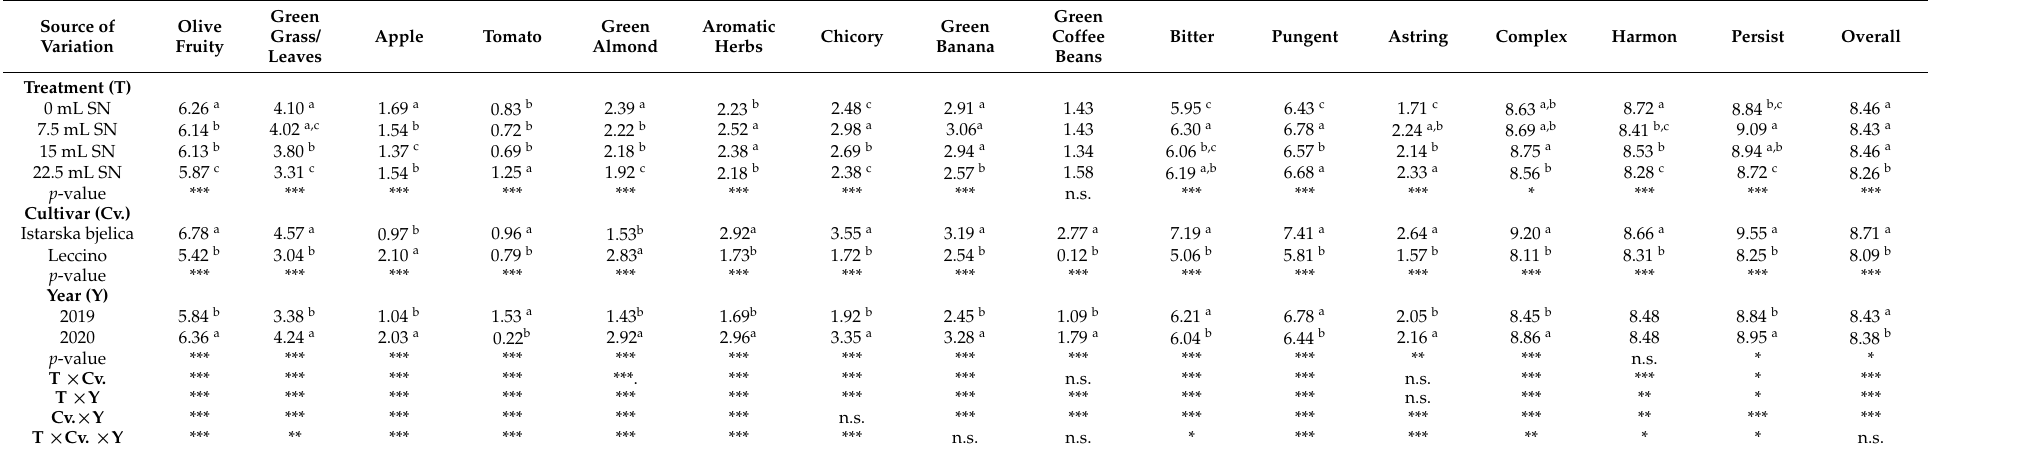
Green Coffee Bitter Pungent Astring Complex Harmon Persist Overall Beans